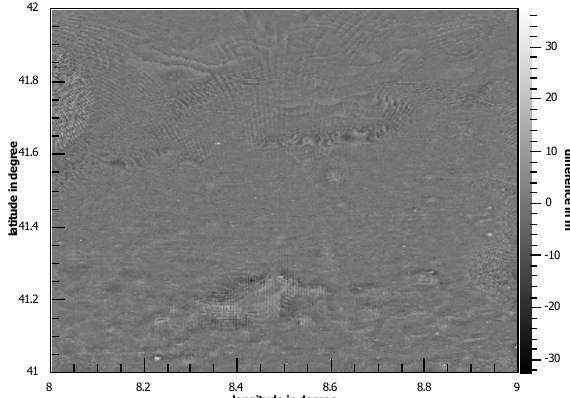
Figure 5: Image of the differences between an original Kaguya DEM tile and a DEM tile extratced from the camera simulation.